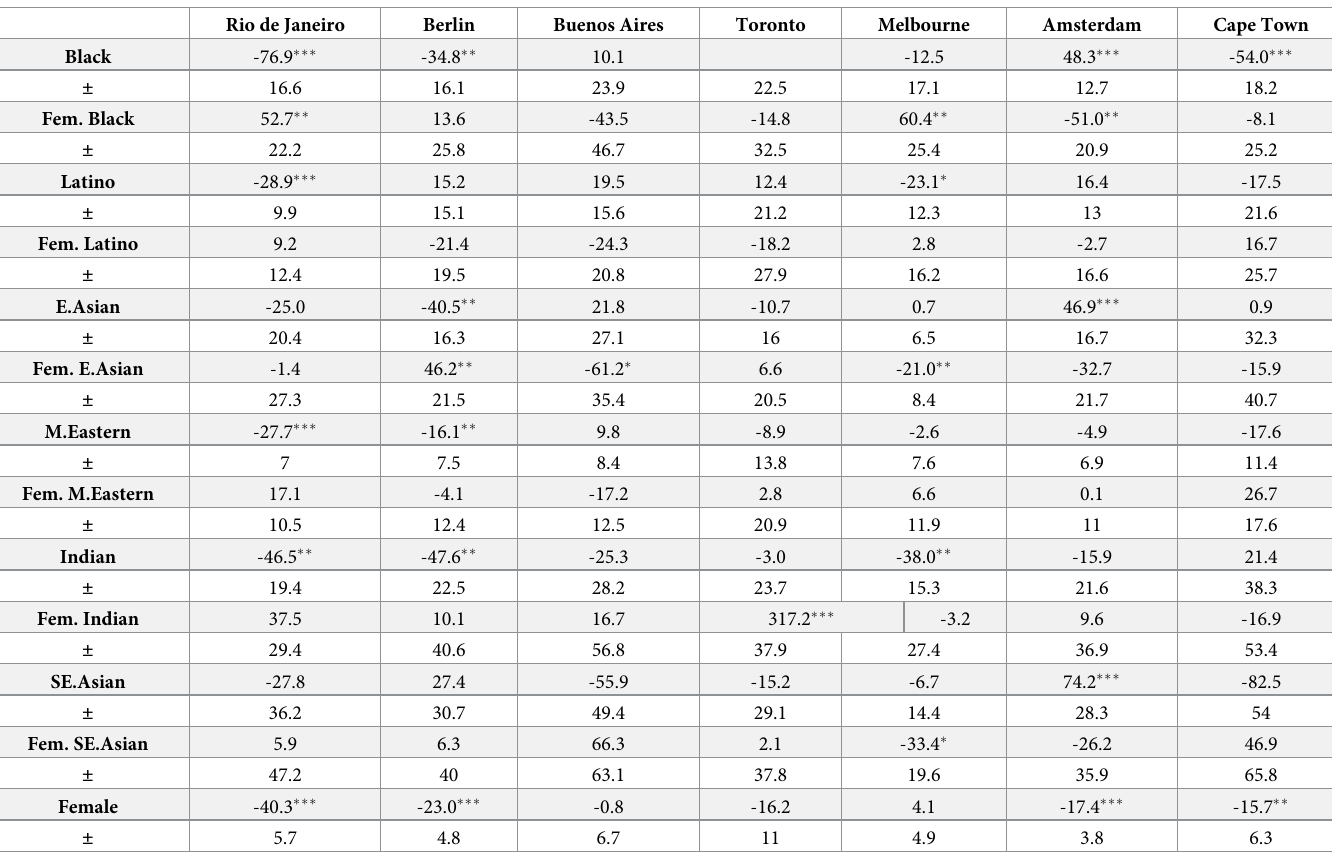
Table 4. To examine the effect of intersectionality of race and gender, we employ a version of the model which includes interaction effects between skin color and gender. Rio de Janeiro